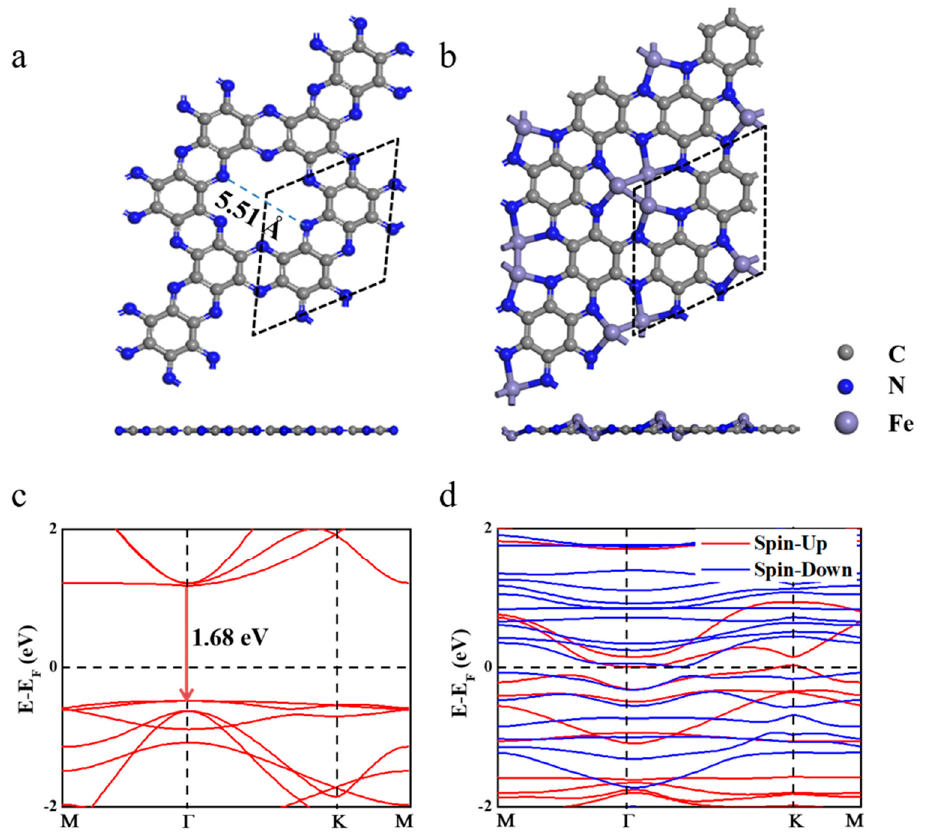
Figure 1. Top and side views of C 2 N ( a ) and Fe 3 @C 2 N ( b ), as well as their corresponding band structures ( c , d ).